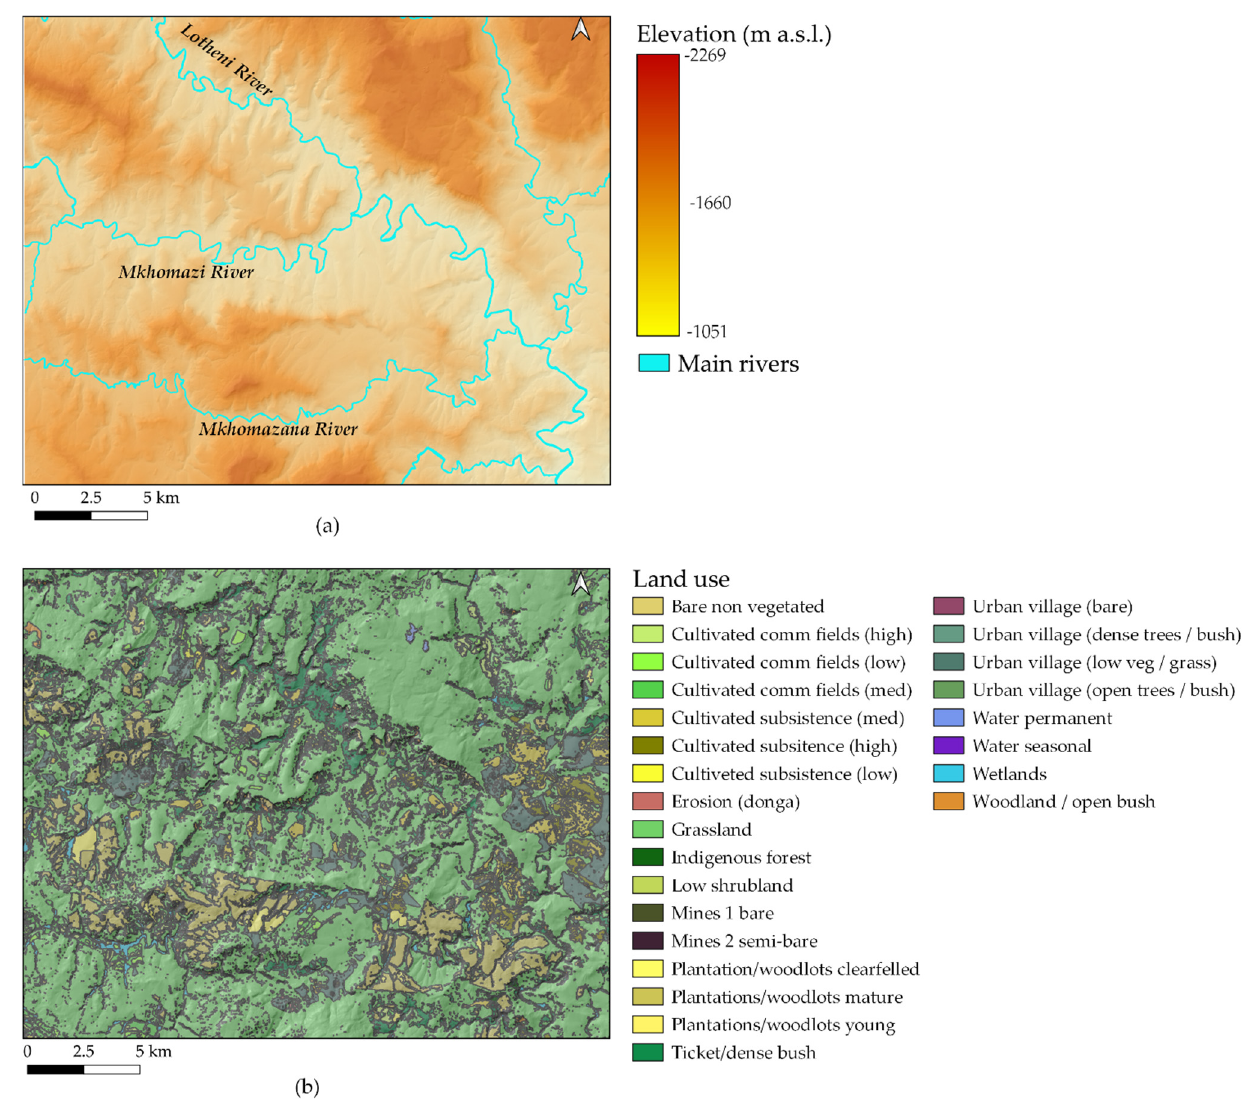
Figure 2. Characteristics of the study area: ( a ) elevation range (derived from the TanDEM-X) and ( b ) land use classes [60].